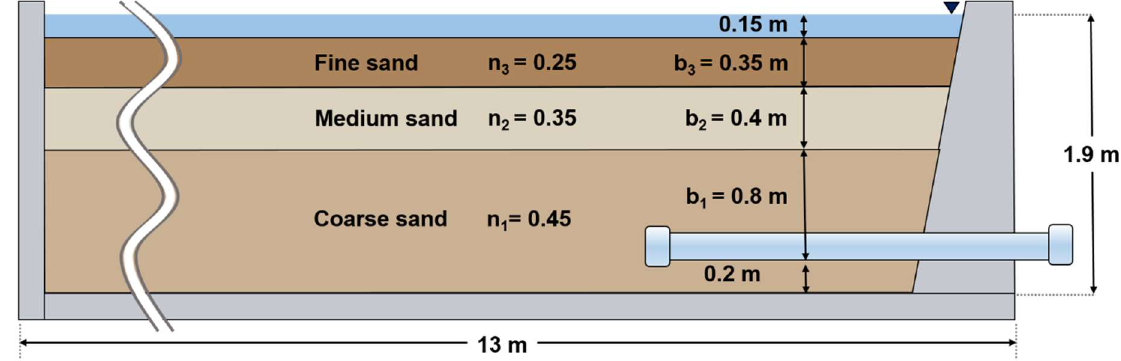
Figure 7. Sand dam with three layers of sand-fill material .